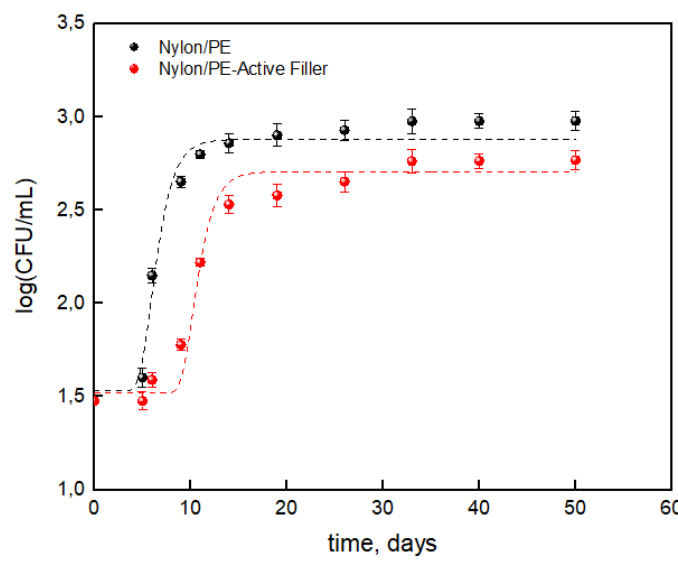
Figure 6. Log(CFU/mL) of TCB on packaged milk during storage time.